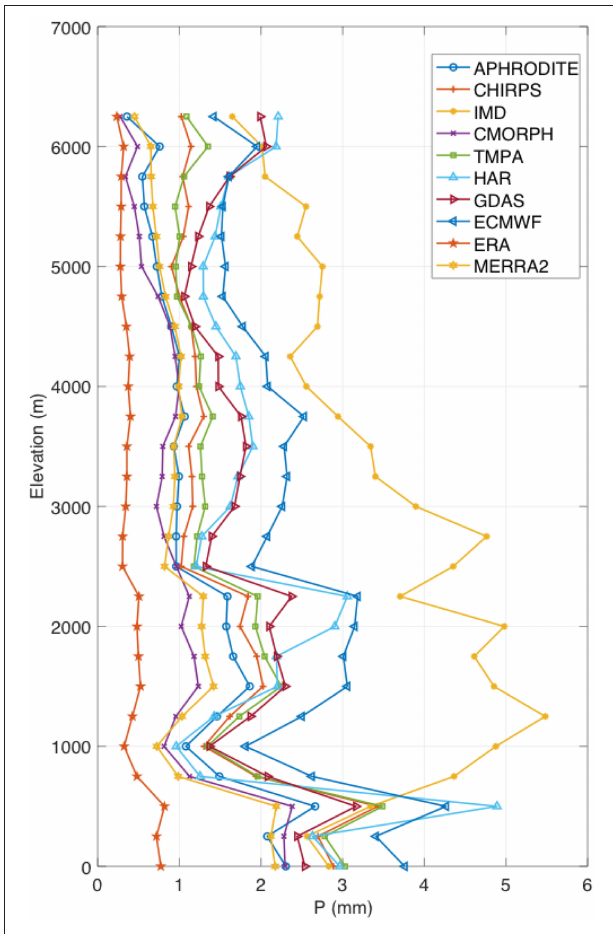
FIGURE 3 | Comparison of the domain-averaged precipitation (P) stratified by elevation. Note that HAR and IMD datasets are limited in their spatial coverage.